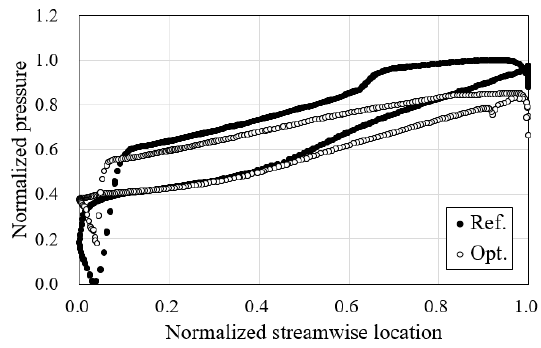
Figure 21. Pressure distributions at 50% span.